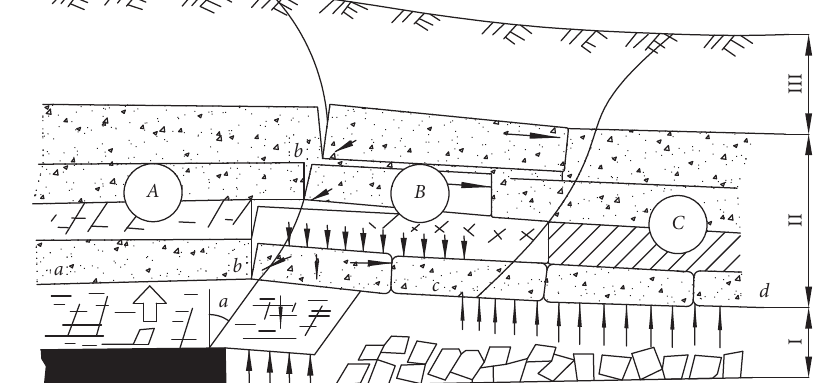
Figure 7: Subareas of overlying strata along advancing direction in mining panel. (A) Intact zone (a-b). (B) Separation zone (b-c). (C) Recompaction zone (c-d). (I) Caved zone. (II) Fractured zone. (III) Bending subsidence zone.The gas drainage method with surface wells is a major means of gas control in Haizi Coal Mine. First well is designed to be 100–150m away from open-off cut and located in the middle of mining panel. Space between surface wells is 300m. Two surface wells are designed in No. 2 1024 panel. The schematic diagram of surface borehole’s layout is shown in Figure 8.